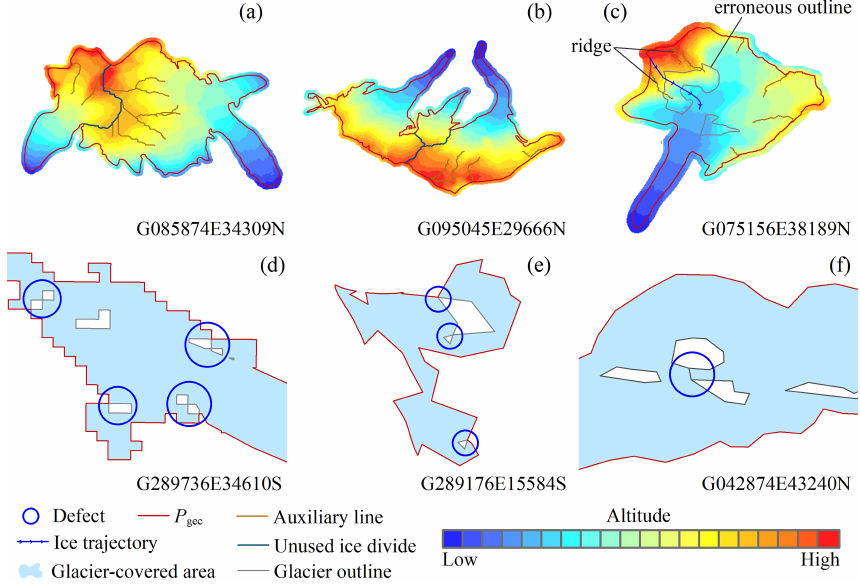
Figure 3. Schematic of three types of flawed glacier outlines. (a–b) Glacier complexes with/without inaccurate segmentation. (c) Erroneous glacier outline caused by vectorization. (d–f) Common problems in flawed glaciers, with defects in the automatic algorithm, defects in post-processing, and artificial errors. The auxiliary line represents lower-grade ice divides in an individual glacier, which is part of the ridge